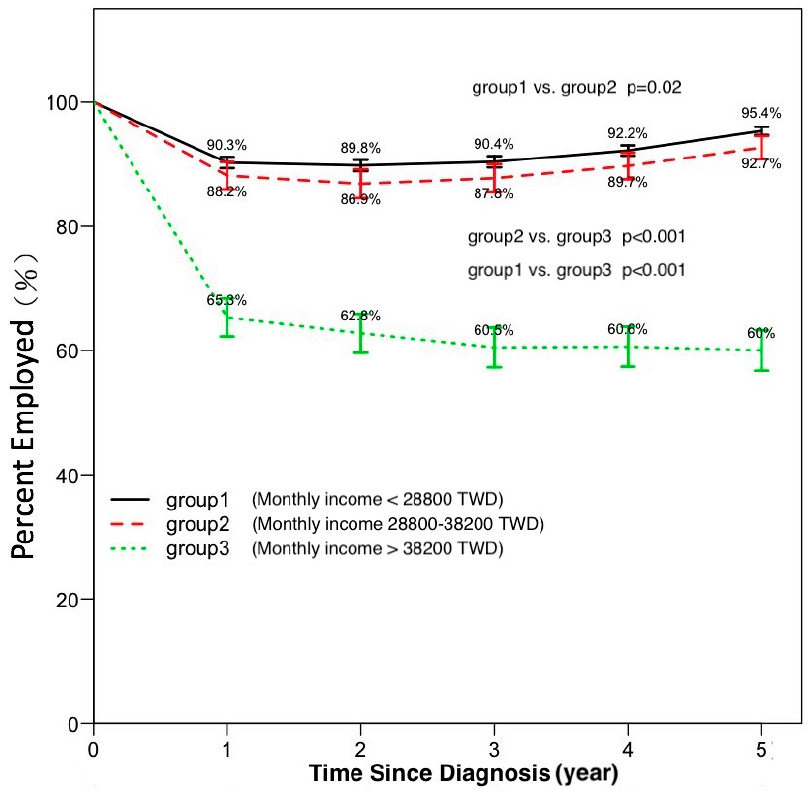
Figure A1. Proportion of return to work within the five-year period categorized by different income of cervical cancer workers.